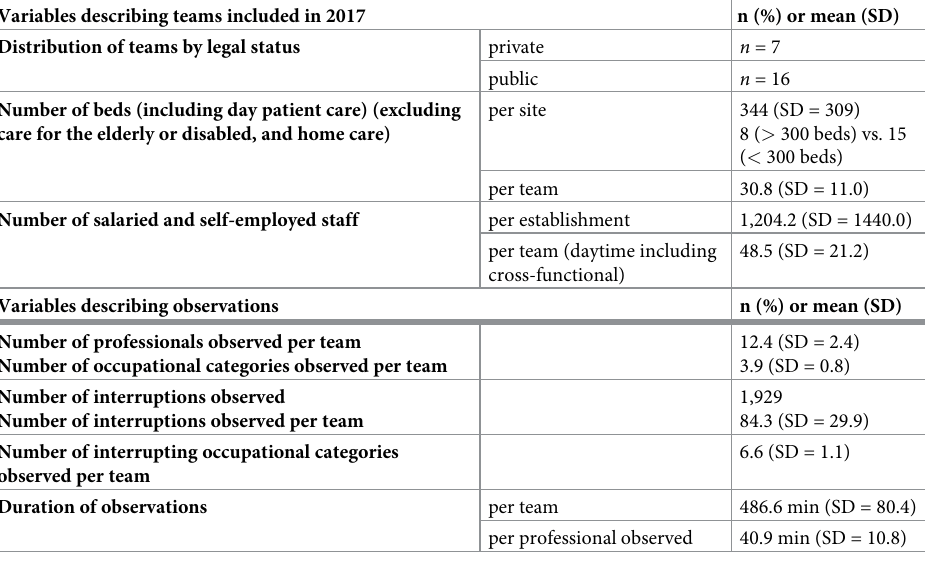
Table 2. Variables and descriptive statistics of participating teams and observations. Variables describing teams included in